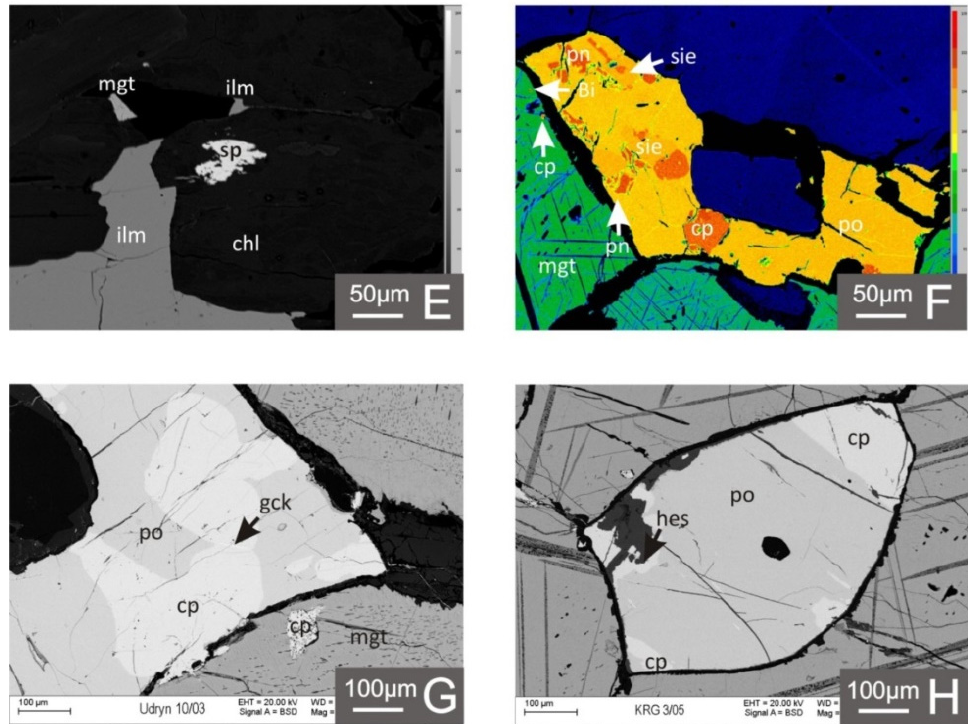
Figure 11. BSE images of characteristic sulphide mineralization hosted by magnetite-ilmenite ores from the Krzemianka and Udryn Fe-Ti-V deposits. ( A ) a typical sulphide aggregate in magnetite (mgt)-ilmenite (ilm) ore, in which the primary pyrrhotite (po) and pentlandite (pn) were subject to secondary mineralization processes. They were replaced by sulphide associations with chalcopy- rite (cp), siegenite (sie), bravoite (brv), and pyrite with smythite (smy) and by thiospinels (spl). ( B ) pyrrhotite (po) grain subject to pyritization (py) within the magnetite (mgt)-ilmenite (ilm) aggregate; galena (gn) insert is present at the border of pyrite and pyrrhotite, cp—chalcopyrite; ( C ) siegenite (sie) replacement of pyrrhotite (cp) along the cracks. Greenockite and galena (gn) grains associated with low-temperature minerals of the chlorite group (chl); py—pyrite; mgt—magnetite; gck—greenockite; ( D ) sulphide aggregate consisting of pyrrhotite (po), chalcopyrite (cp), siegenite (sie), pentlandite (pn), and Co-bearing pyrite (Co-py), BSEI false colors; ( E ) sphalerite (sp), sur- rounded by chlorites (chl) in the ilmenite-magnetite ore; ( F ) native bismuth (Bi) inclusion in magnetite (mgt); the aggregate consists of pyrrhotite (po), chalcopyrite (cp), pentlandite (pn), and siegenite (sie), BSEI false colors; ( G ) greenockite (gck) vein in chalcopyrite (cp) and pyrrhotite (po) aggregate hosted by magnetite (mg). Greenockite can be a secondary product of the supergene alteration of Cd-rich sphalerite; ( H ) hessite (hes) inclusion in chalcopyrite (cp) and pyrrhotite (po) aggregate hosted by magnetite-ilmenite ore, BSE. Table 3. The basic statistical parameters of the chemical composition of pyrrhotite, chalcopyrite, cubanite, talnakhite, and pyrite from the Krzemianka and Udryn Fe-Ti-V deposits. Mineral Value Fe S Ni Co pyrrhotite arithmetic mean 59.53 (FeS) standard deviation ( n = 61) minimum content maximum